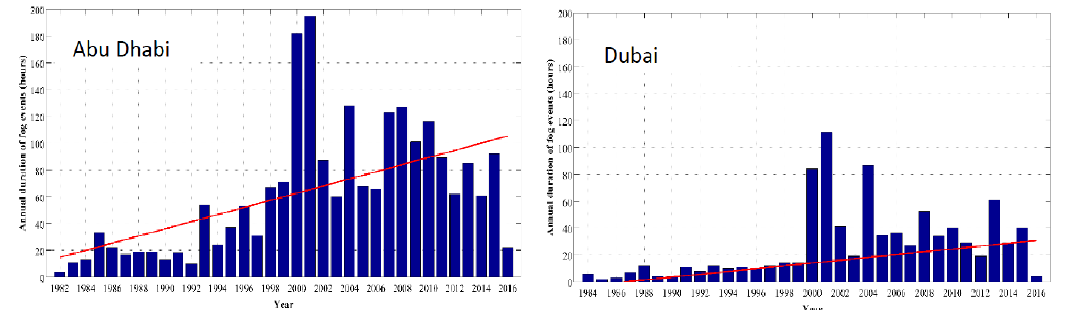
Figure 9. Total annual hourly fog events of Abu Dhabi and Dubai from the years 1982–2016, and 1984– 2016, respectively.